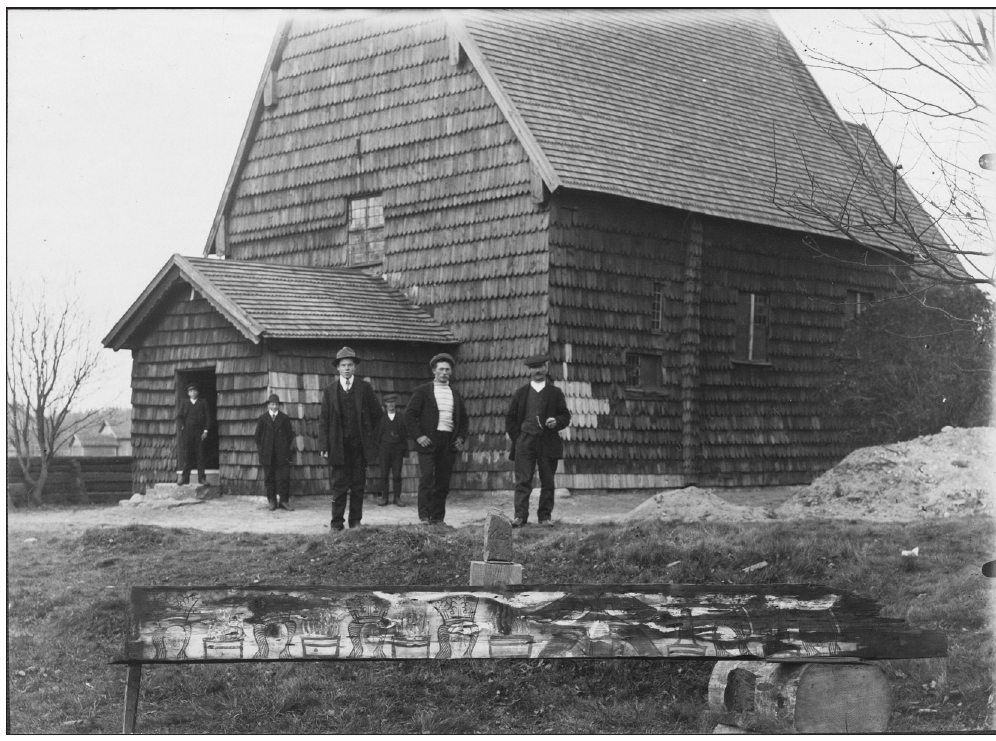
Figure 3: The painted log, displayed in the foreground as the main attraction of the picture, was found beneath the roof of the sacristy in Södra Råda old church. We do not know who the men were, neither when the photograph was taken or by whom. (Photographer and year unknown. Source: Swedish National Heritage Board. Photo id. 3180-019. Public